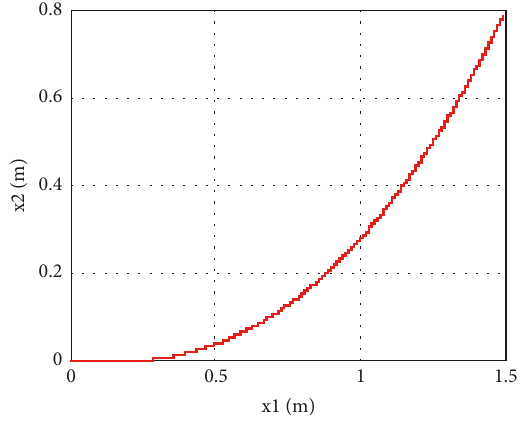
Figure 3: Robot trajectory.